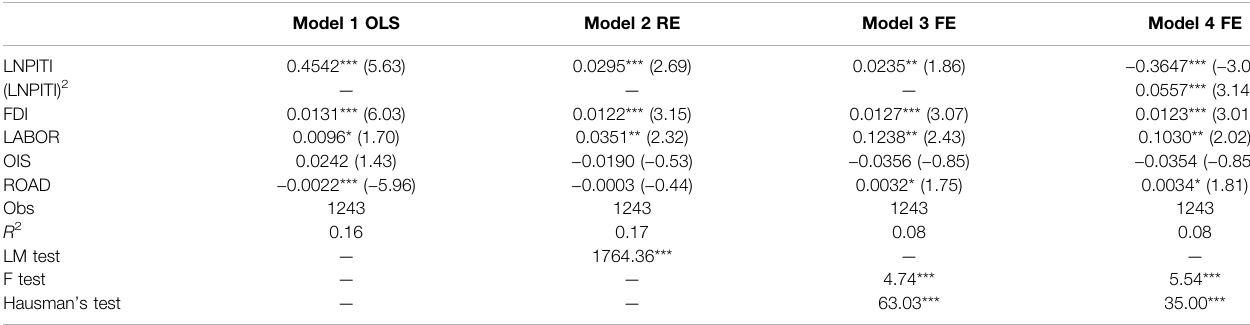
TABLE 2 | Empirical results of in fl uencing factors of UGEE.